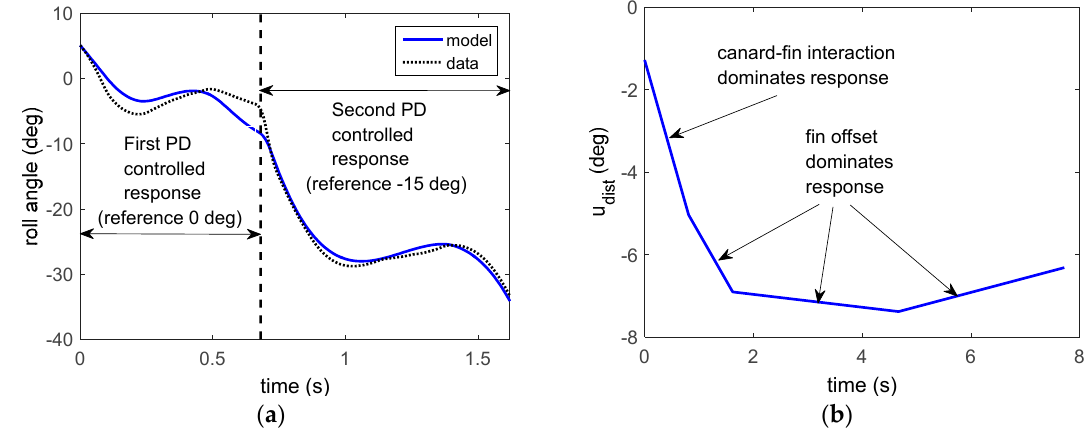
Figure 21. ( a ) Zoomed in roll angle response versus data; ( b ) Identified disturbance.